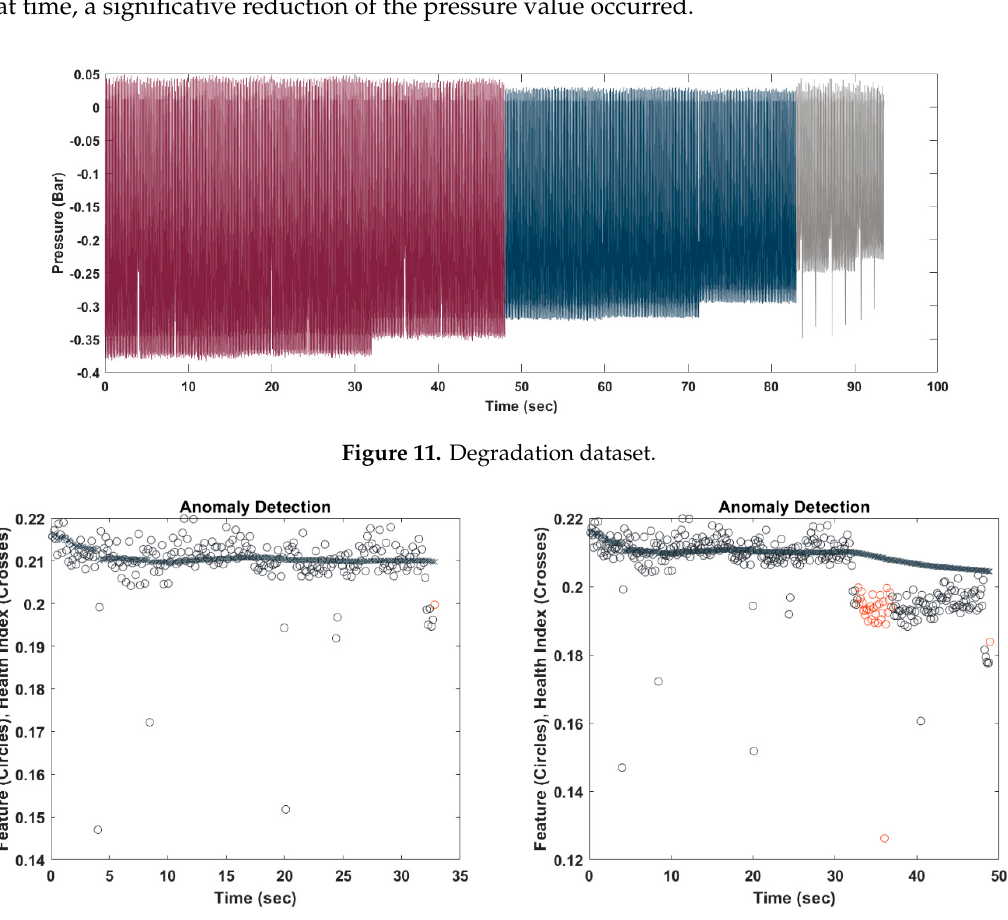
Figure 12. ( a ) Anomaly detection until the anomaly threshold. ( b ) Anomaly detection until the failure threshold.